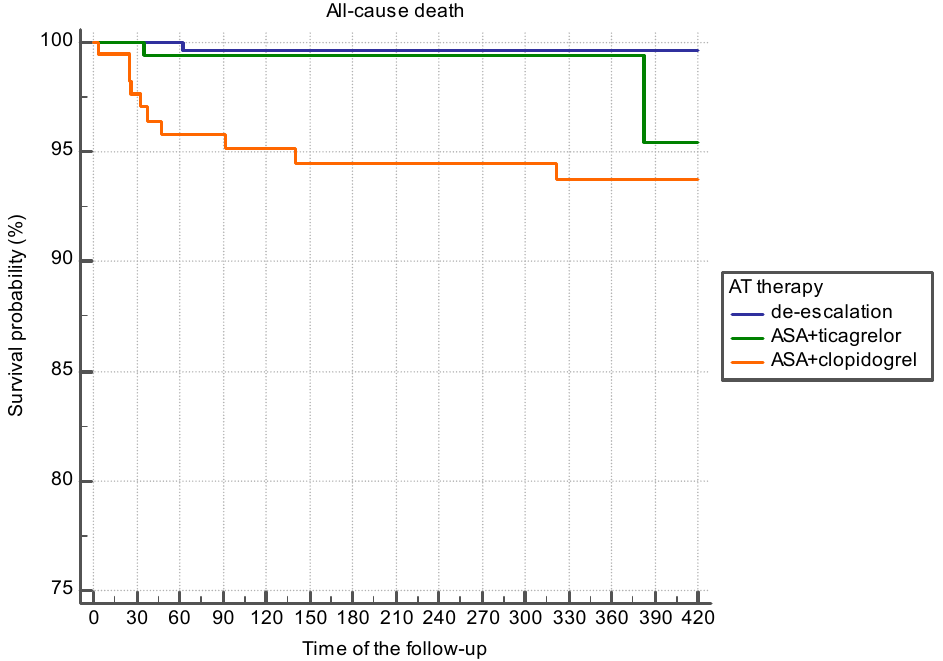
Figure 5. Survival probability of patients under 67 years depending on the APT options (Kaplan–Meier analysis).